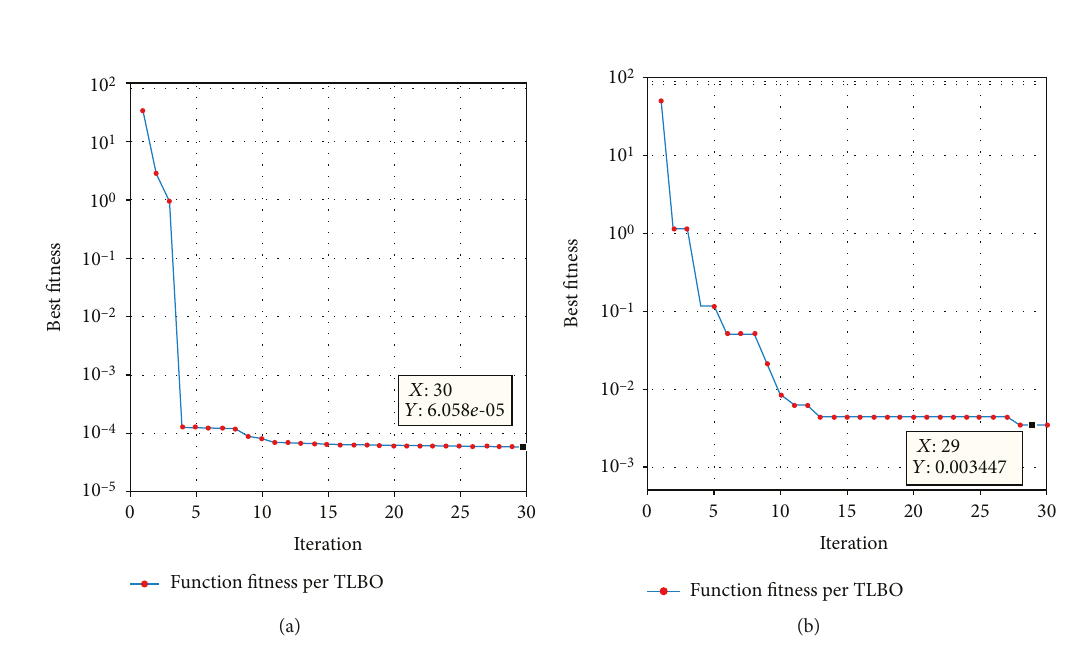
Figure 7: Convergence of the fi tness function of the inner loop i Table 1: Controller parameters of the U